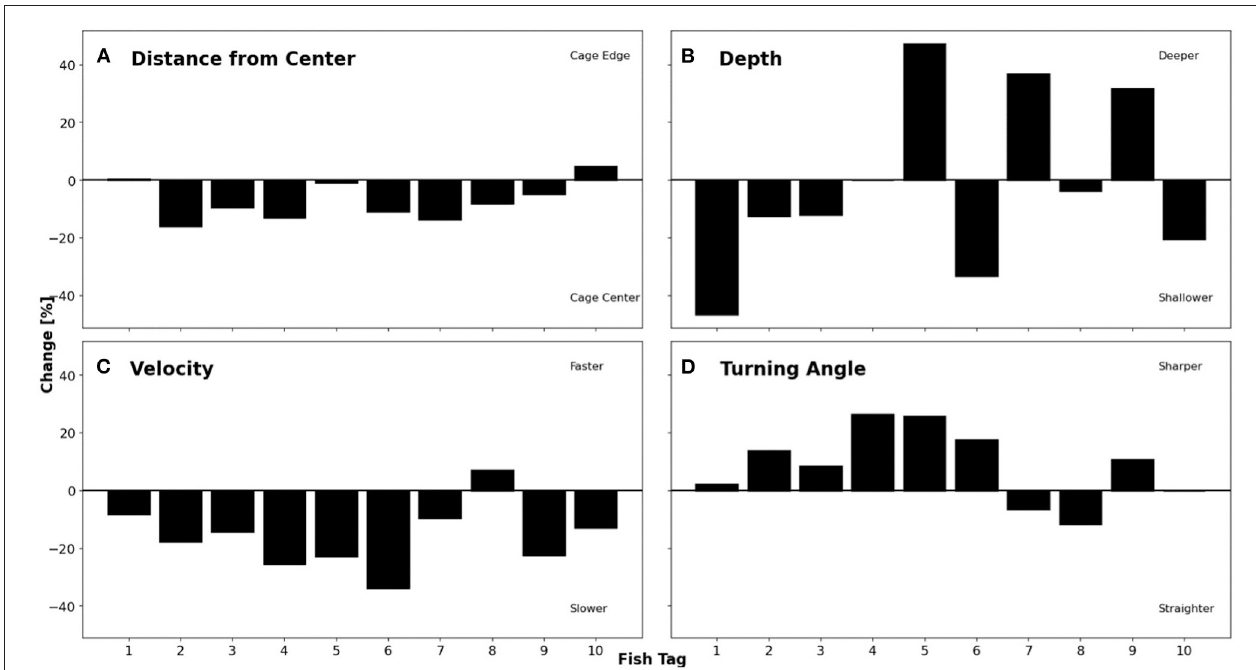
FIGURE 7 | Percent change of individual fish comparing before the fall overturn (1–16 October) temperature and DO change to after (19–31 October). (A) Change in distance from centre where a positive change represents a shift towards cage edge. (B) Change in depth where a positive change signifies movement towards the bottom. (C) Change in velocity where an increase in velocity is represented by a positive change. (D) Change in turning angle with a positive change representing a sharper turning angle.